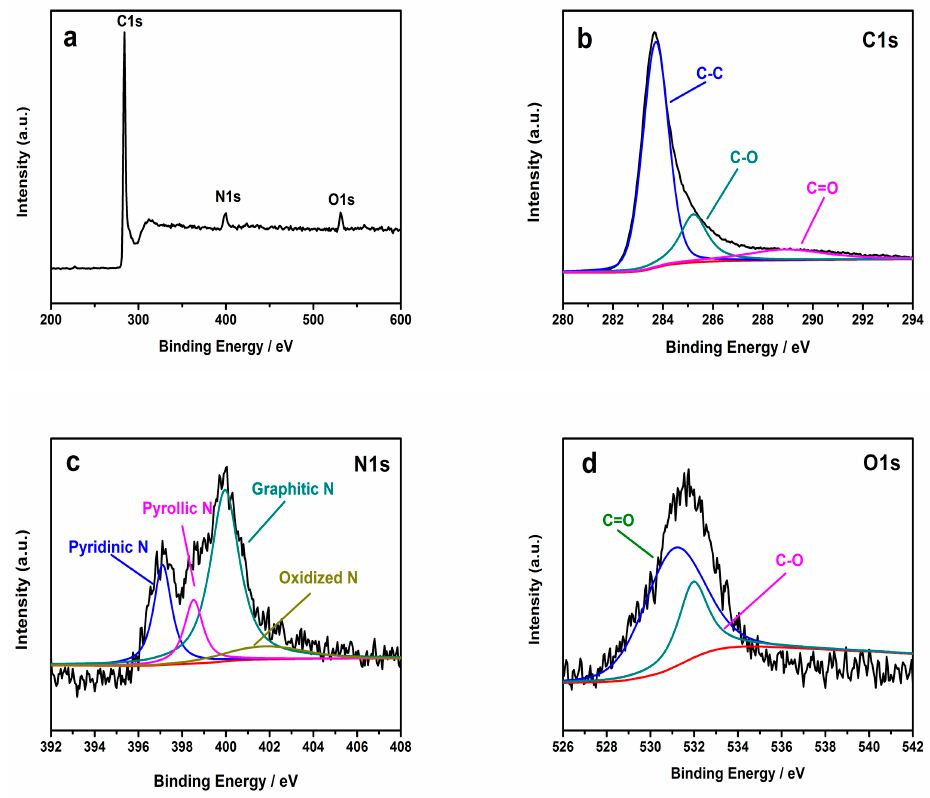
Figure 2. XPS spectra of 3D-CNFs ( a ) and high-resolution XPS spectra for C1s ( b ), N1s ( c ), and O1s ( d